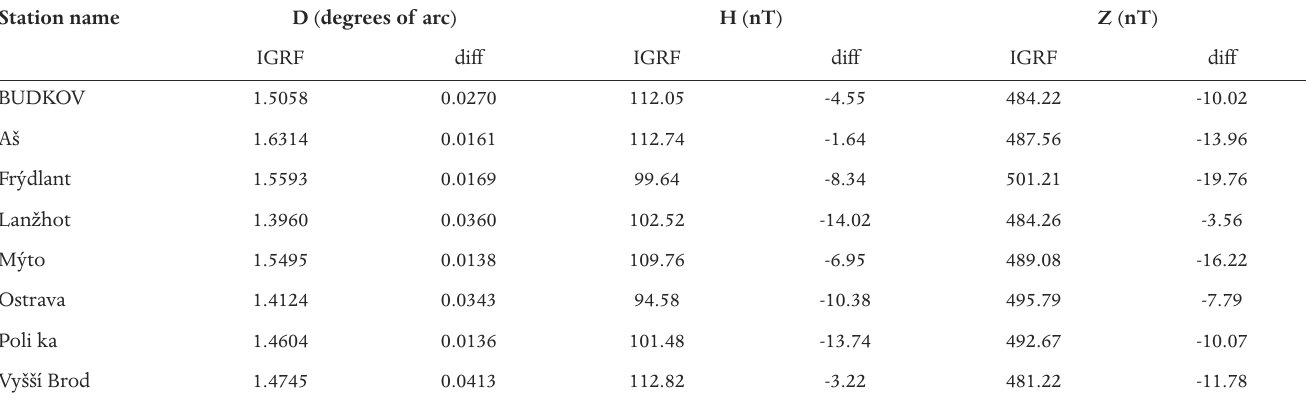
Table 2. Secular variation between 1995.5 and 2010.5 epochs and its linear model; error = observed_value -